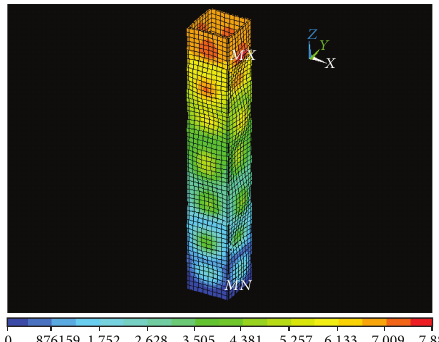
Figure 24: Typical computed deformed shapes of HS-50-20-T2.